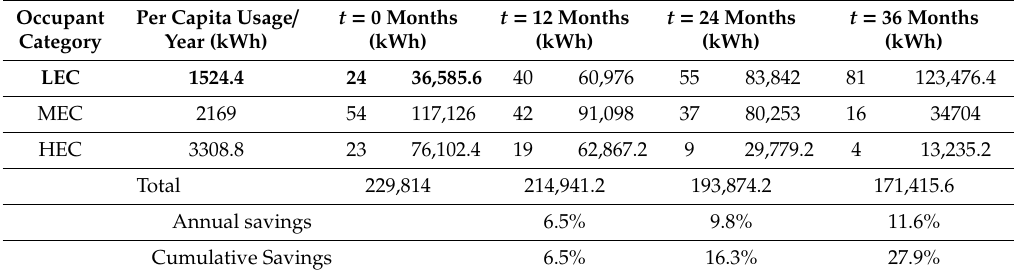
Table 10. The di ff erence in energy usage before and after